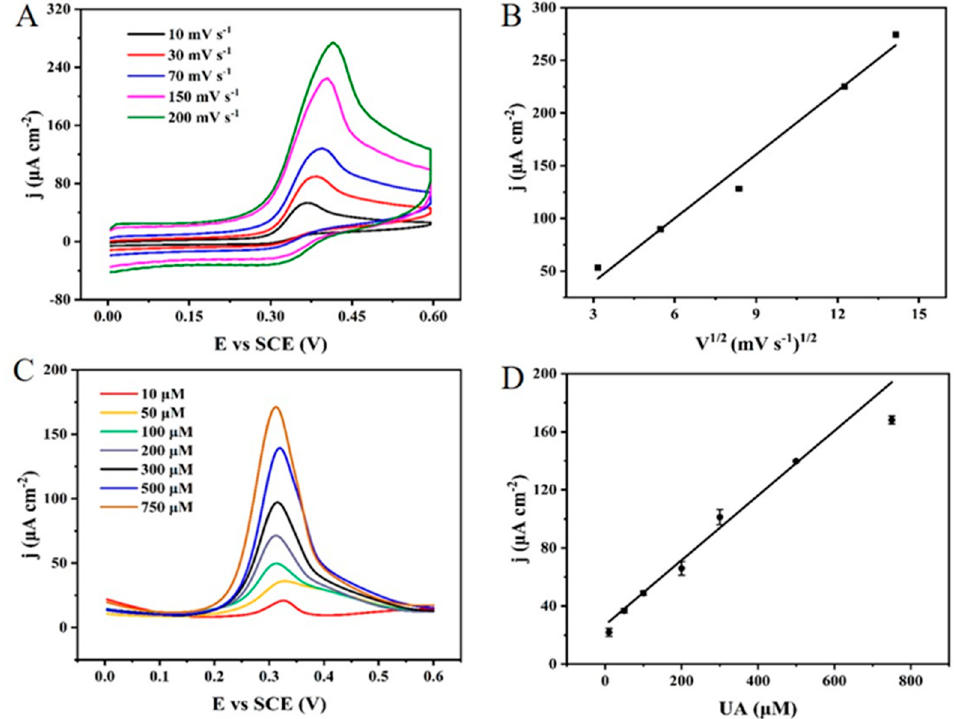
Figure 3. ( A ) The CV curves of the NPG/GCE in PBS (50 mM, pH 6.0) containing 1.0 mM uric acid at different scan rates. ( B ) The linear relationship between the oxidation peak current density of uric acid and the square root of scan rate for the electrooxidation of 1.0 mM uric acid. ( C ) The DPV curves of the NPG/GCE in PBS (50 mM, pH 6.0) containing different concentrations (10 to 750 μ M) of uric acid. ( D ) The linear relationship between the oxidation peak current density of uric acid and uric acid concentration.